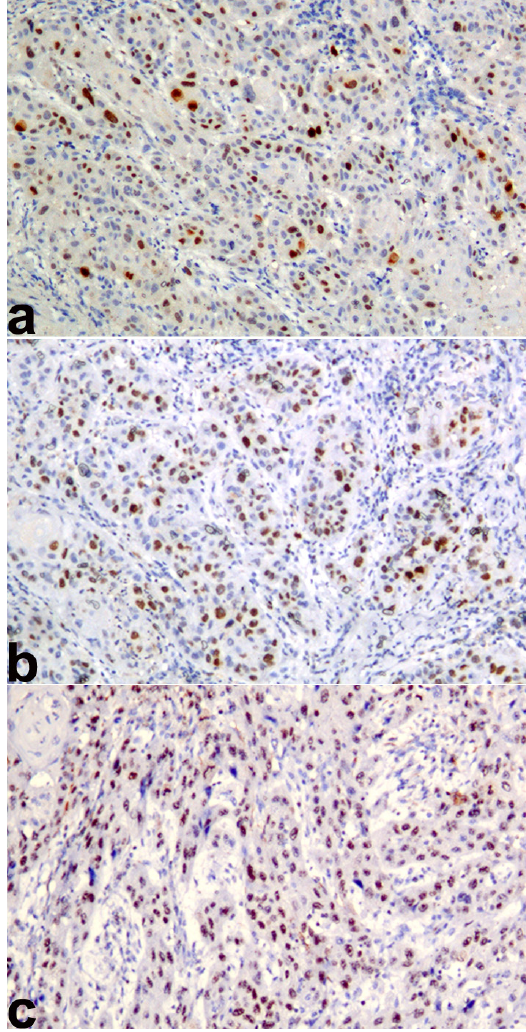
Figure 2- Photomicrograph showing Ki67 antigen expression (Ki67 labeling index) in oral squamous cell carcinoma a) Low Ki67 labeling index (≤45), b) Moderate Ki67 labeling index (46 to 60) and c) High Ki67 labeling index (≥61). (Immunohistochemistry; Magnification